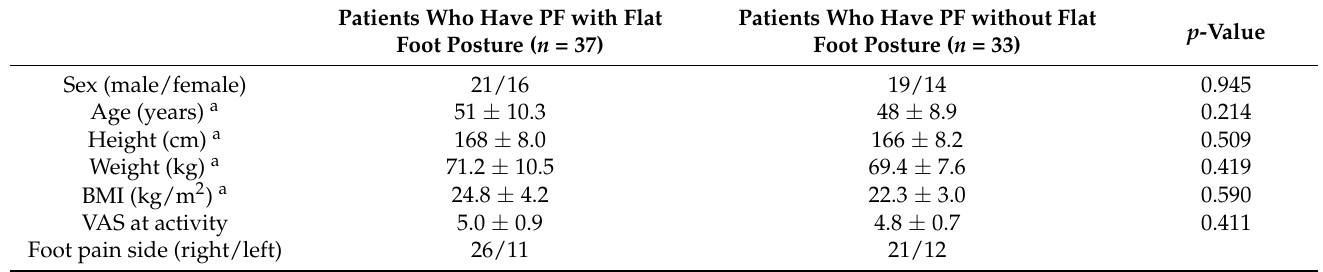
Table 1. Demographic data of enrolled patients who have PF with and without flat foot posture. Patients Who Have PF with